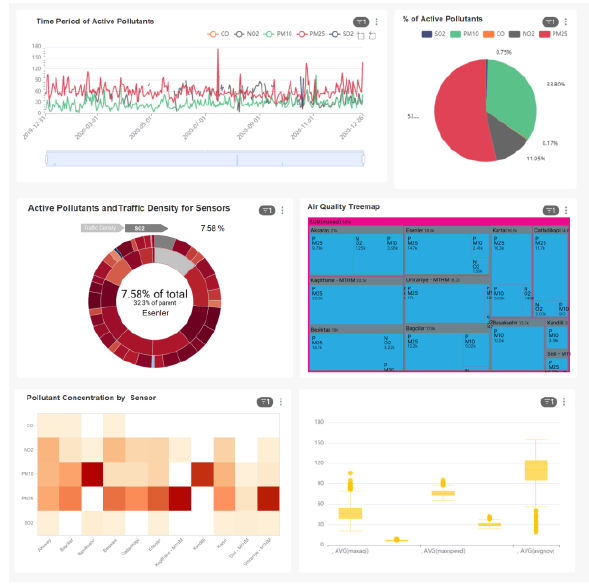
Figure 9. Designed GIS-based Dashboard Example for Istanbul